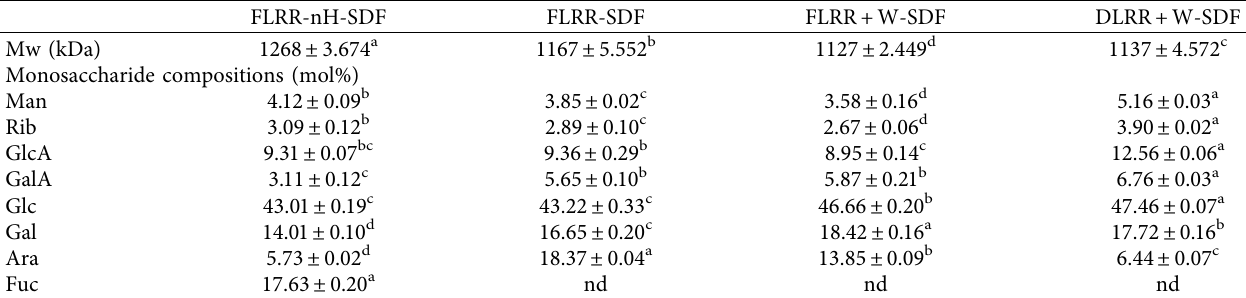
Table 3: Molecular weights and monosaccharide compositions of FLRR-nH-SDF, FLRR-SDF, FLRR+W-SDF, and DLRR +W-SDF samples from LRRs.